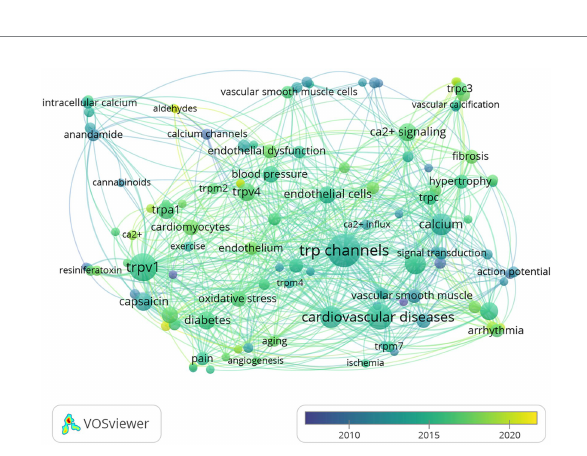
FIGURE 8 The co-occurrence analysis of keywords was shown by the co- occurrence of keywords normalized in the Linlog/modularity method, weighted by an occurrence for each plot.